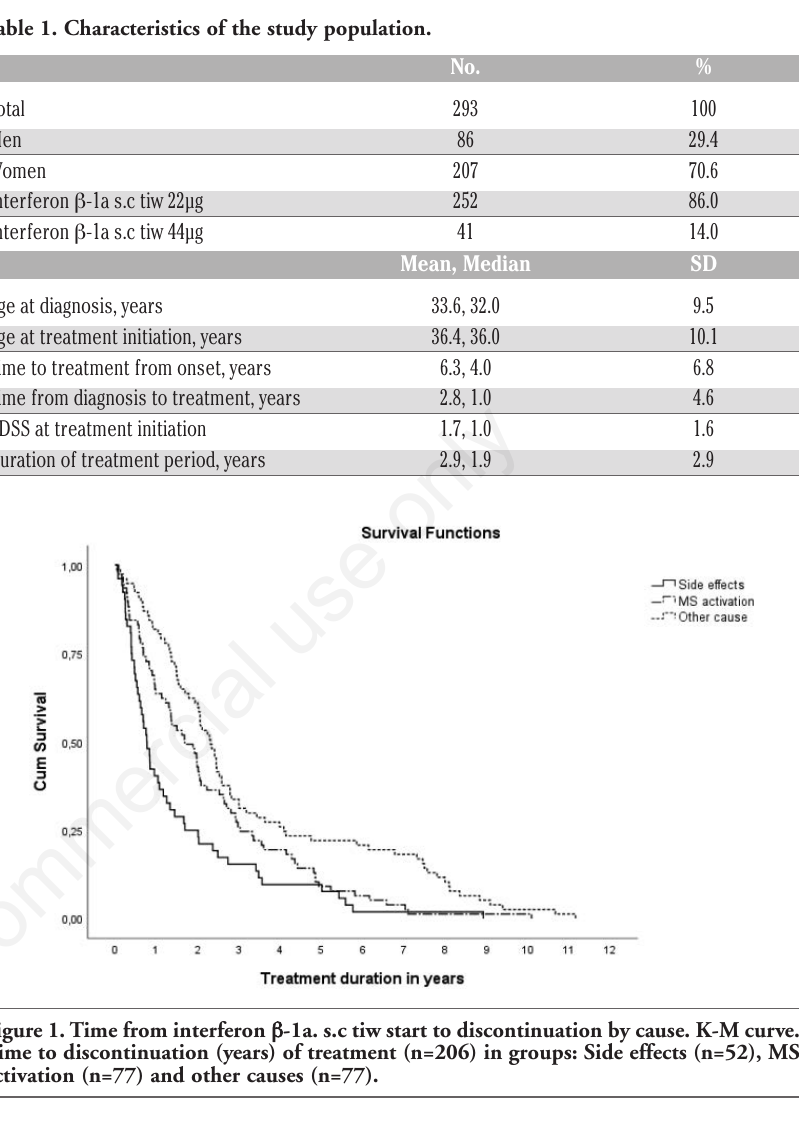
Table 1. Characteristics of the study population.